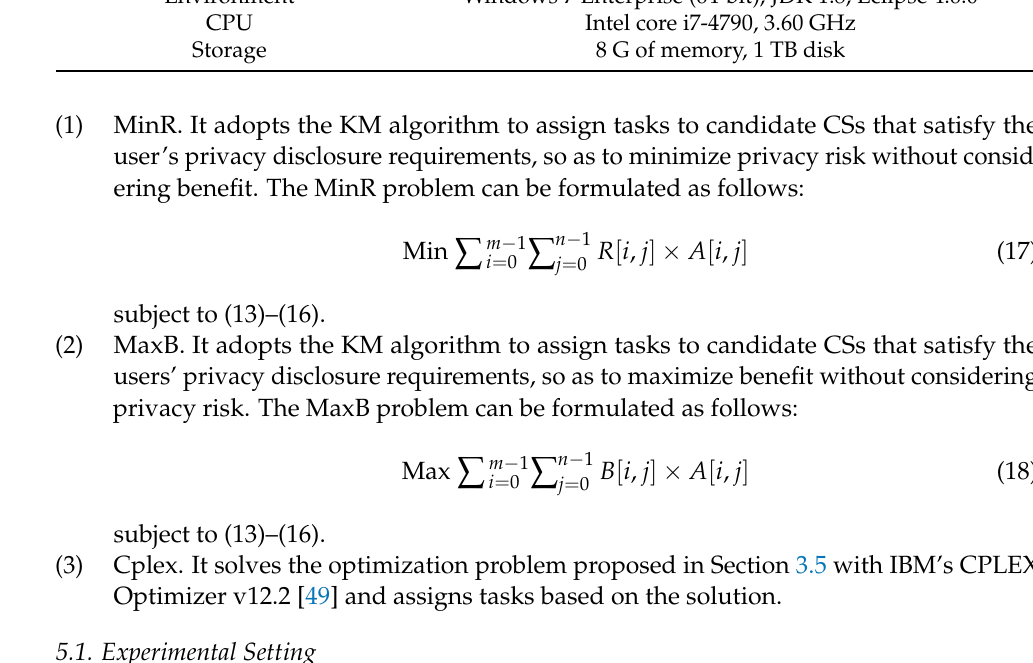
Table 4. The hardware and software configurations.